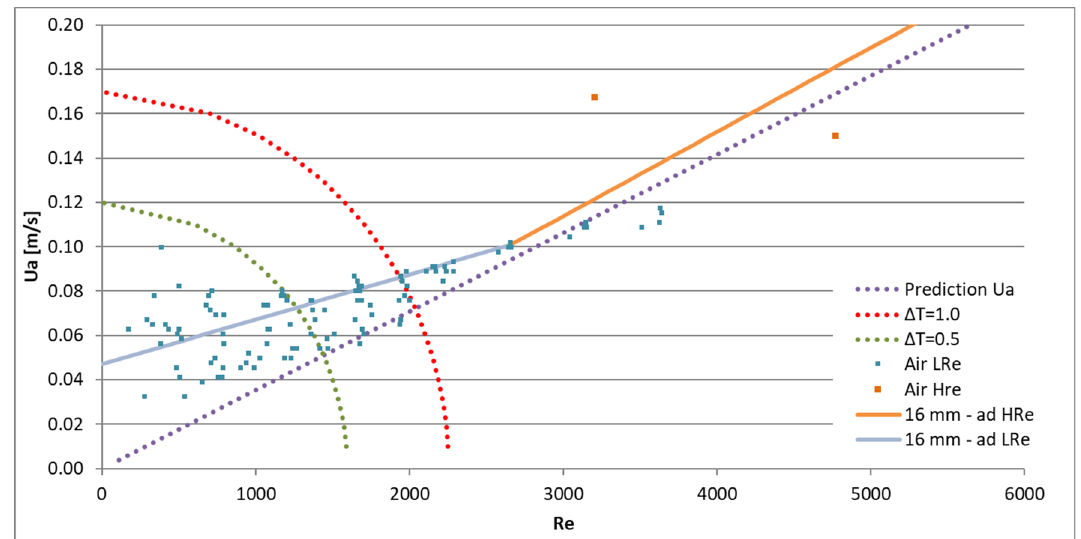
Figure 17. Comparison of the predictions of Equations (4)–(6) and (9) with the test results.